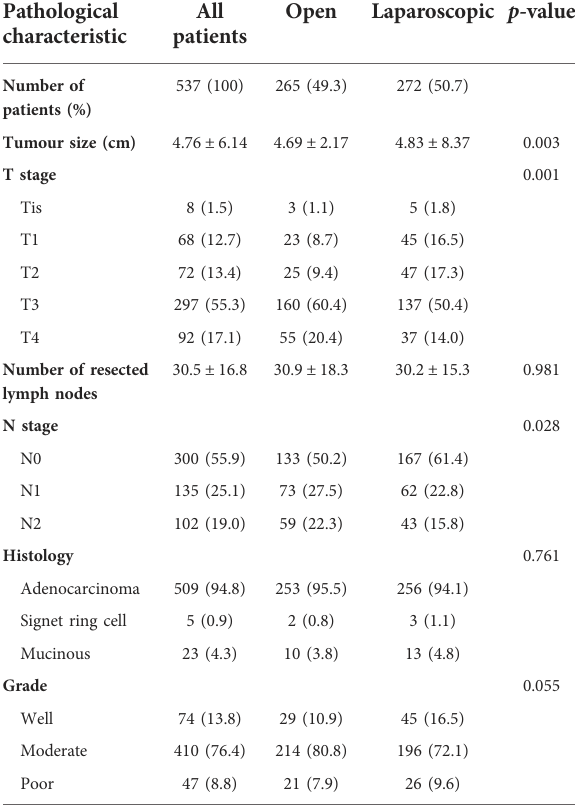
TABLE 3 Pathological characteristics of the study population. Pathological